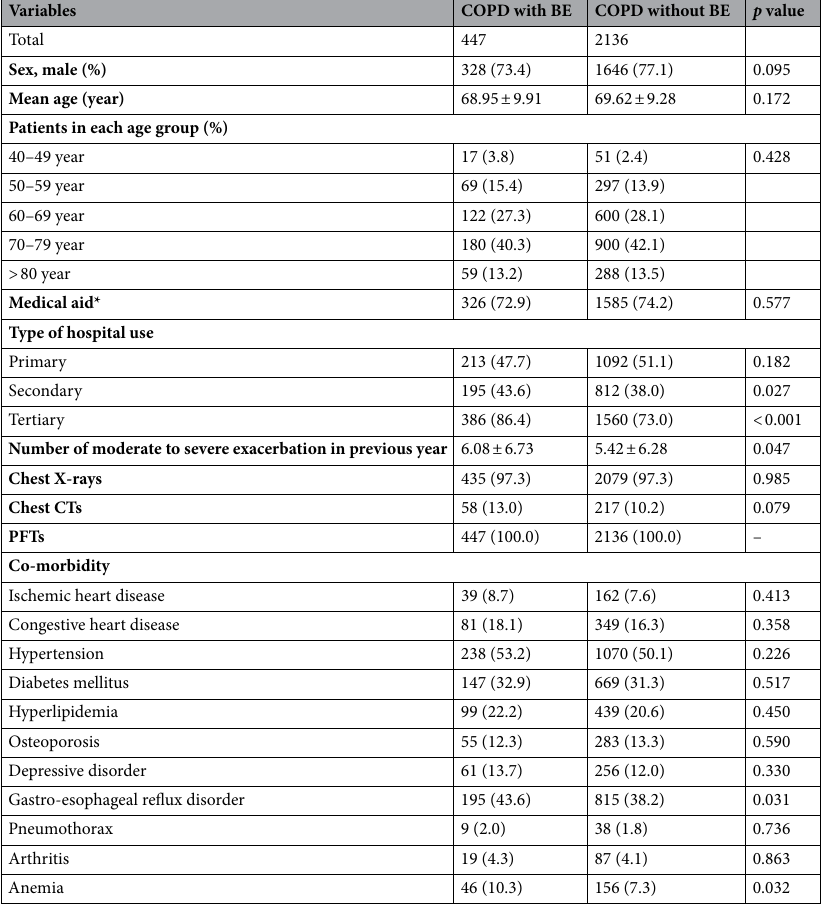
Table 1. Baseline characteristics of study populations. Data are expressed as mean ± standard deviation or N (%). Propensity score matching was performed in this study population, considering age, sex, and medical